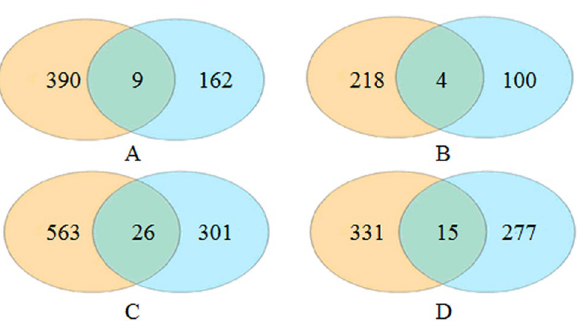
Figure 14. The Venn plot of the differential metabolites between diets and distal intestine contents groups in positive ( A , C ) and negative ( B , D ) modes (n = 12). Note: The red area represents the specific differential metabolites in intestinal contents of the SBM20_N group ( A , B ) or SBM40_N group ( C , D ) compared to the FM_N group, the blue area represents the specific differential metabolites in the diets of the SBM20_N (A, B) or SBM40_N (C, D) groups compared to the FM_N group. The overlapping area represents the co-contained metabolites of diets and DI